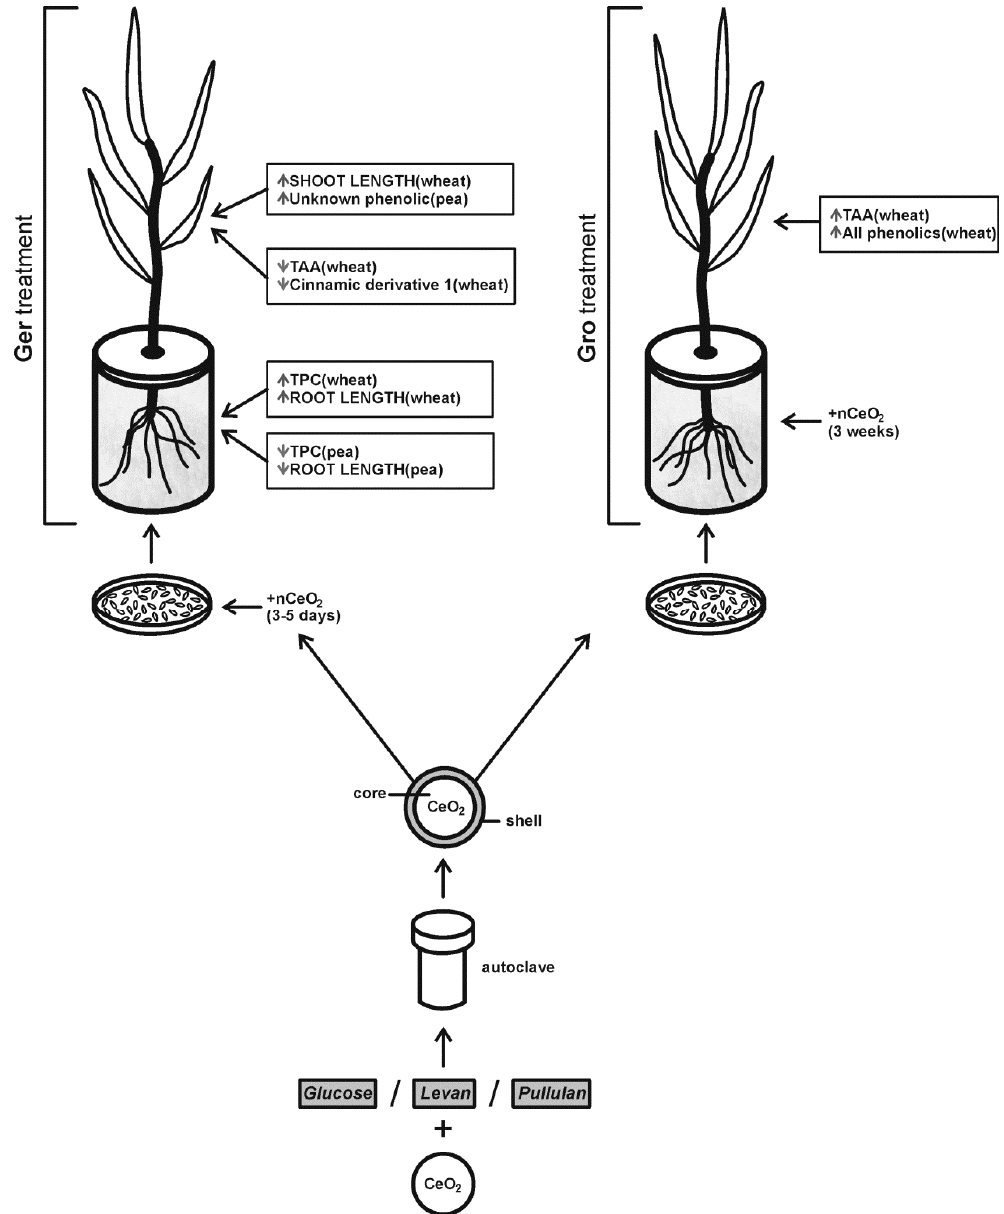
Figure 9. Scheme of the main effects of different nCeO 2 on the studied plant species. Ger and Gro treatment: during germination and during growth, respectively. TPC and TAA: total phenolic content and total antioxidative activity, respectively. ↑ , ↓ indicate an increase and decrease, respectively.